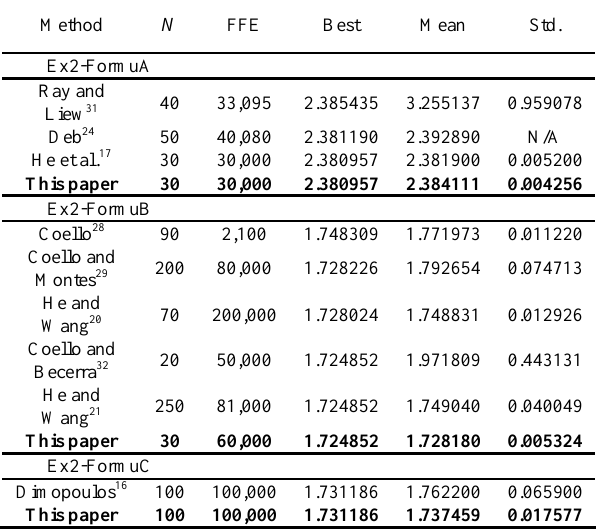
Table 7. Statistical results of different methods for the welded beam design